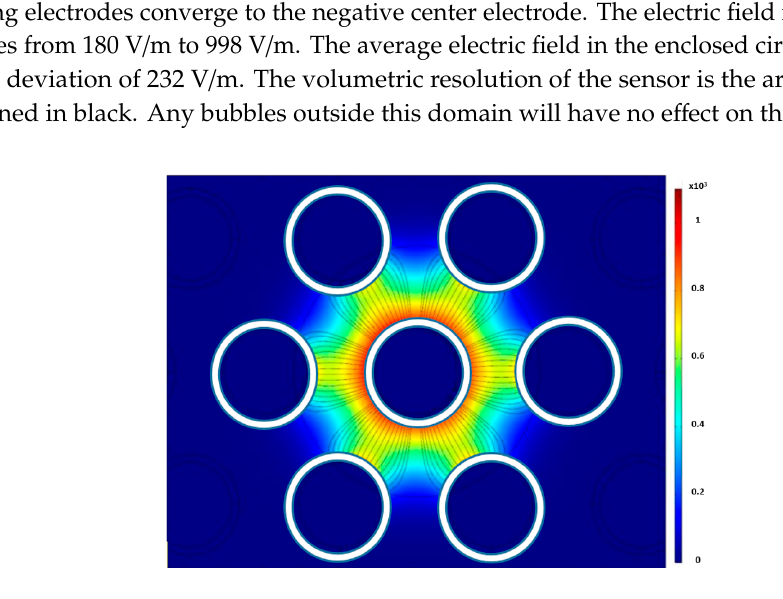
( b ) Figure 11. Electric field contour for bubble diameters of ( a ) 7 mm and ( b ) 9 mm. Figure 12. Effect of the axial location of the bubbles on the normalized capacitance. The next set of runs were done to determine the effects of bubble locations relative to other bubbles on the overall normalized capacitance value. Two sets of sixteen air bubbles were created in